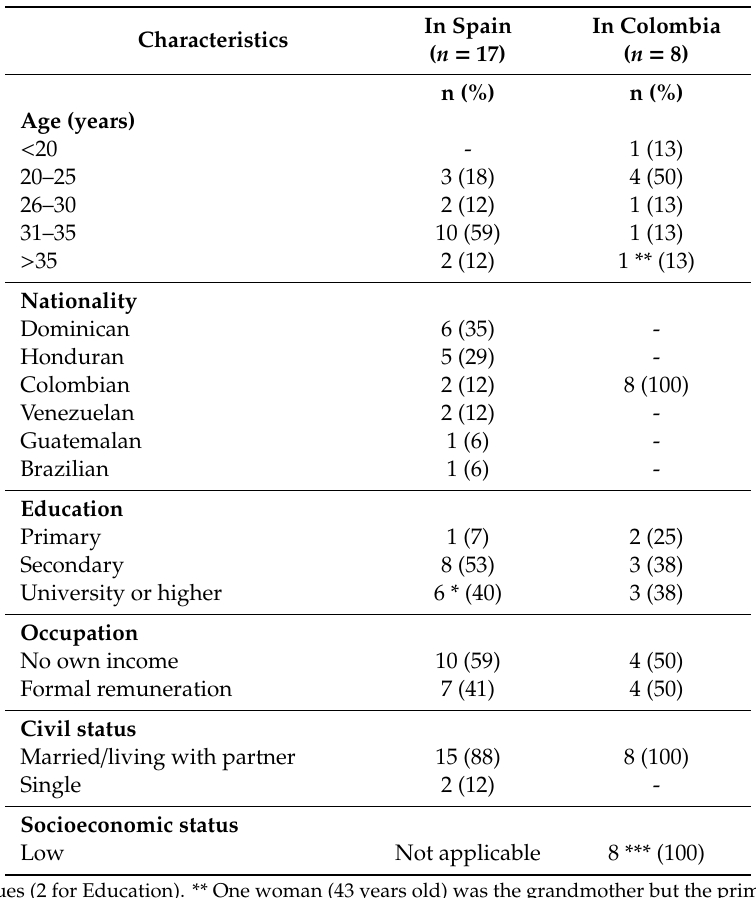
Table 1. Sociodemographic characteristics of women participating in the